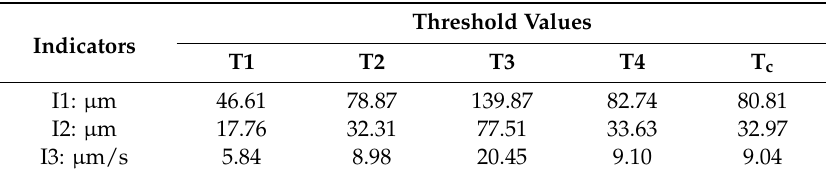
Table 2. Threshold values for all aural discomfort levels.